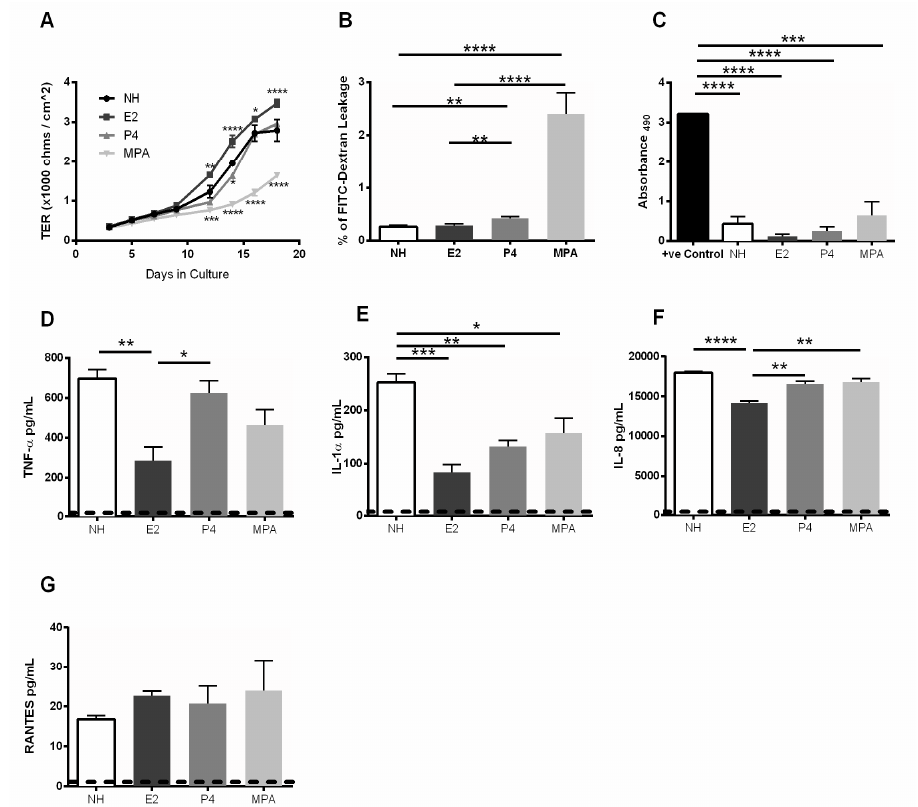
Figure 2. Estrogen treatment reduces barrier leakage and decreases pro-inflammatory cytokine response in primary genital epithelial cells. Primary GECs were grown in the absence (NH = no hormone) or presence of sex hormones E2, P4 or MPA until confluent. ( A ) TER was measured every alternate day starting day 3 post-seeding of cells. ( B ) Following hormone treatment in confluent GEC monolayers, cells were incubated for 24 h with FITC-dextran dye applied to the apical side. 24 h later, 50 µ L of basolateral supernatant was collected and FITC-dextran dye was measured using a microplate reader. Dextran leakage was expressed as a percentage of FITC-dextran added to the apical compartment. ( C ) Supernatants taken from confluent monolayers grown in presence of hormone and contraceptive were assessed for LDH release to determine cell stress and cytotoxicity. ( D – G ) Supernatants from GECs grown in the presence of E2, P4 or MPA were collected and analyzed for the presence of TNF- α , IL-1 α , IL-8, and RANTES. Dashed line indicates lowest detection limit of individual cytokine and chemokine in an assay. Data shown is representative of 6–9 separate experiments done on 6–9 di ff erent tissues taken from di ff erent donors and shown as mean ± SEM. Each experiment had 3 replicate cultures for each experimental condition. Statistical significance is indicated: **** p < 0.0001, *** p < 0.001, ** p < 0.01, * p < 0.05.